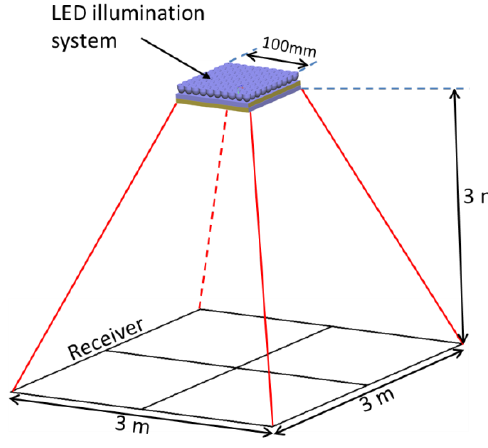
Figure 8. Illustration of the simulation structure for efficiency analysis.